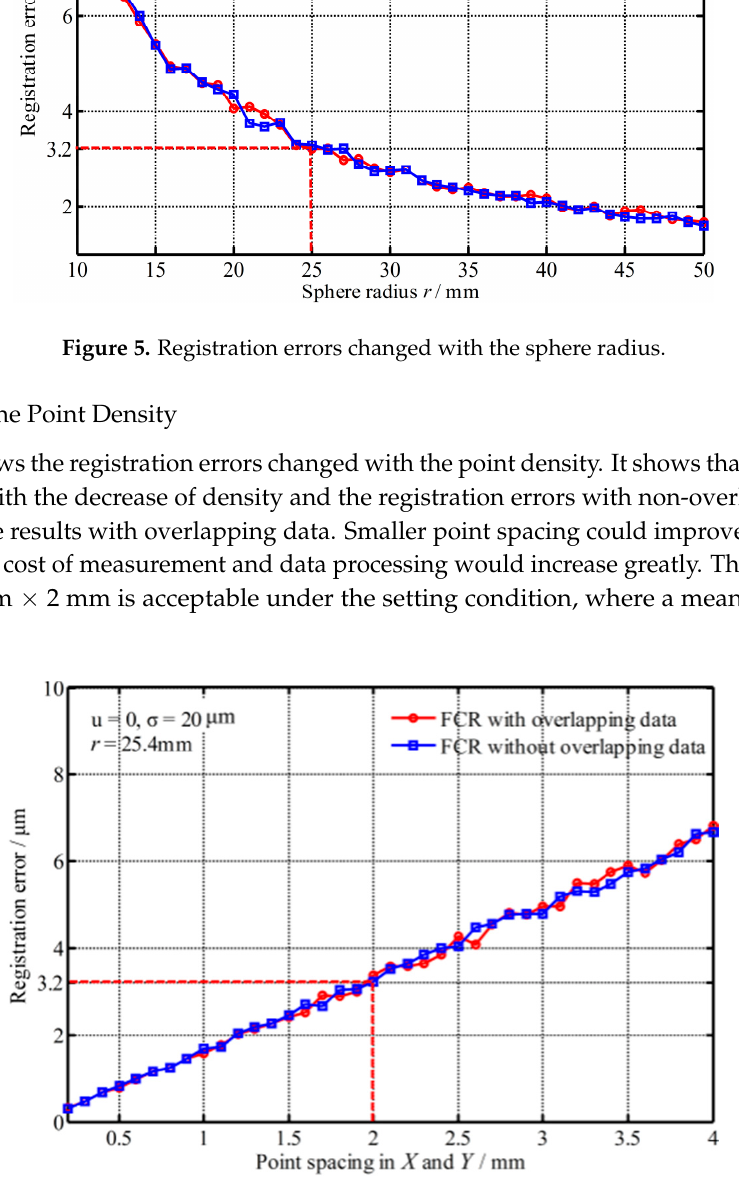
7 of 14 Figure 4. Simulation point clouds of sphere targets, ( a ) the relative positions of the sphere targets; ( b ) simulation sphere surface; ( c ) extracted point clouds with overlapping data; and ( d ) extracted point clouds with non-overlapping data. Generally, the target size, density of registration points, noise in registration points, and overlapping ratio may cause radius bias and position errors in sphere centers. So the registration precision is mainly affected by those factors. Simulations are conducted by varying the target size, density, noise level, and its anisotropy respectively, in which simulations are repeated 200 times with randomly re-generating simulation points. The mean value of the biases between the registered points and their theoretical positions is calculated for the registration result each time, and a mean value of those mean values is calculated for the final registration error, as following Equation (8): ' 1 1